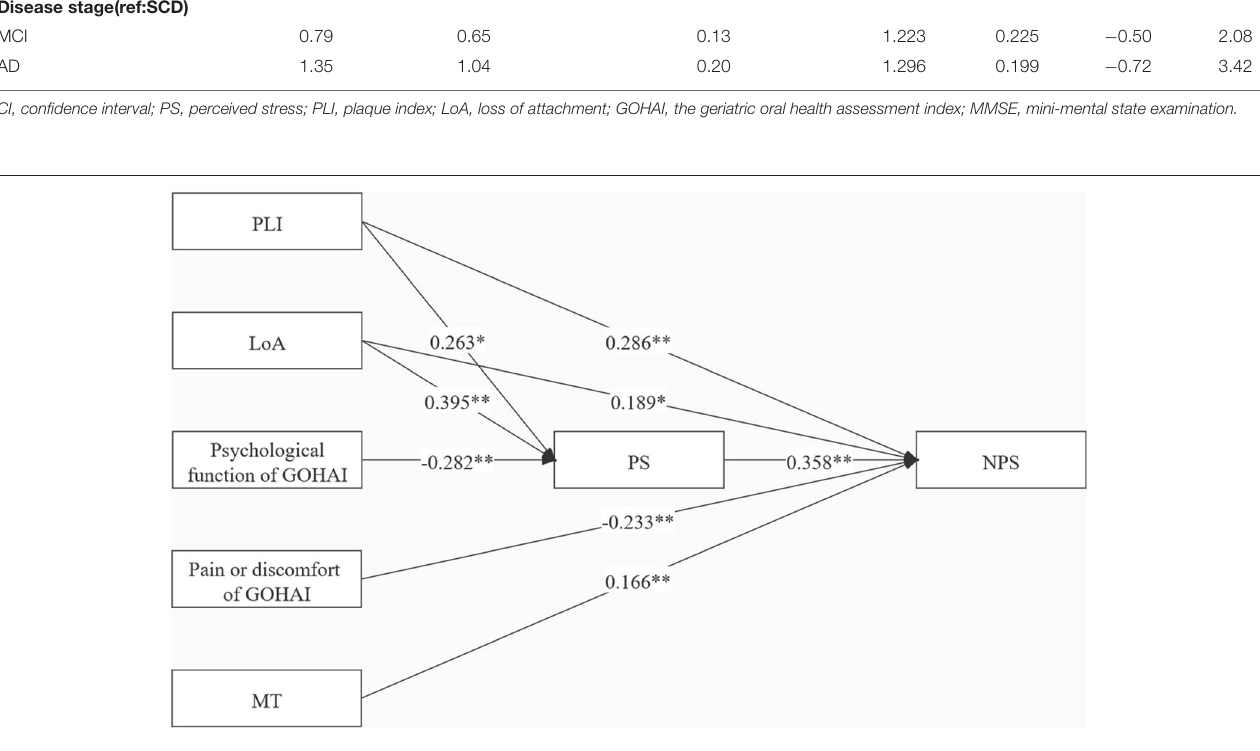
Frontiers in Aging Neuroscience |